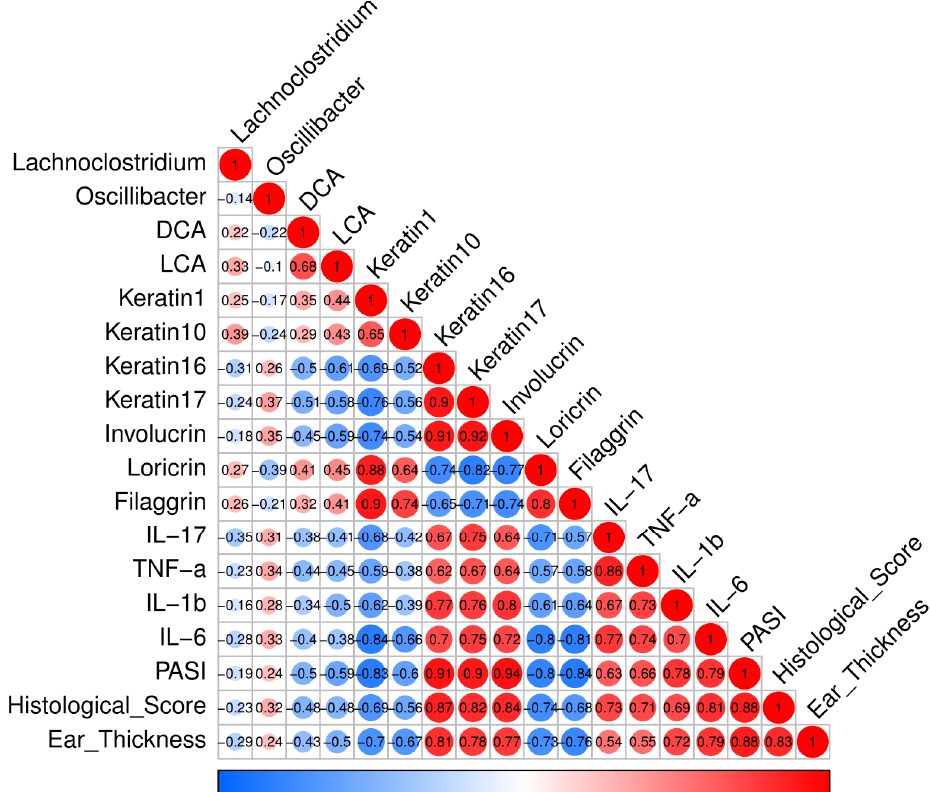
Figure 12. Correlation analysis with R-value of the altered genera, colonic bile acids, psoriasis indices, epidermal structural proteins, and cutaneous cytokines.